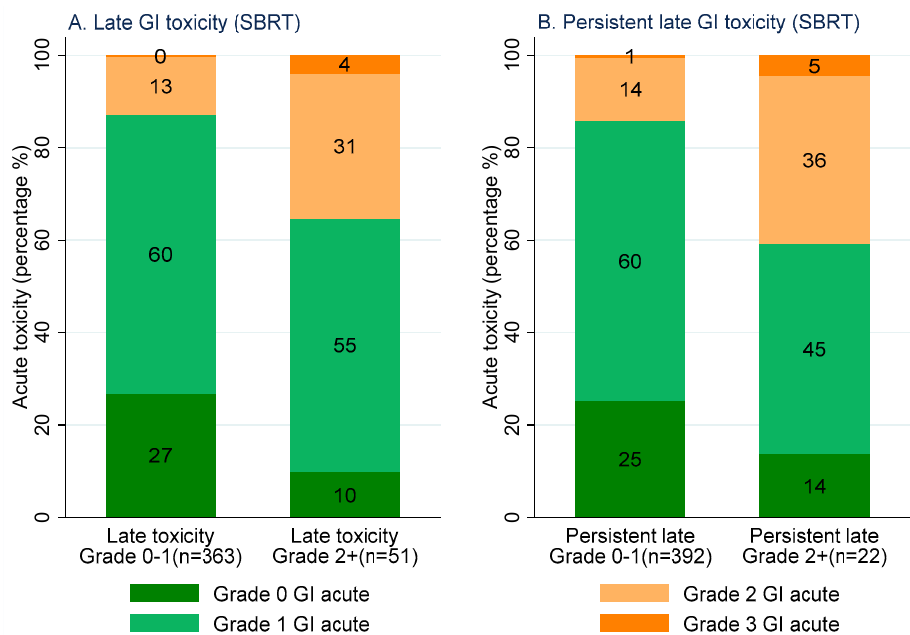
Figure 3. Stacked bar graph: maximum grade CTCAE acute GI toxicity experienced for patients with Grade 0–1 (left of each figure) and Grade 2+ (right of each figure) late GI toxicity following SBRT ( left ). Maximum grade CTCAE acute GI toxicity experienced by patients with grade 0–1 (left of each figure) and grade 2+ (right of each figure) persistent late GI toxicity following SBRT ( right ). Univariable and multivariable logistic regression for predicting worst grade 2+ late GI toxicity (6–24 months) and persistent grade 2+ late GI toxicity in the SBRT group is presented in Table 4. In the univariable analysis baseline EPIC-26 bowel sub-domain score was predictive for late grade 2+ GI toxicity ( p = 0.004). Acute grade 2+ GI events ( p < 0.0001) and worst EPIC-26 bowel sub-domain score in the acute setting ( p = 0.04) was also predictive for grade 2+ late GI toxicity. In univariable analysis, acute grade 1+ rectal bleeding ( p = 0.04), grade 2+ diarrhoea ( p = 0.01) and grade 1+ rectal pain ( p < 0.0001) were individually associated with late rectal toxicity. The remainder of the baseline and treatment factors did not demonstrate a statistically significant association. In multivariable analysis, acute grade 2+ GI toxicity (OR 3.68, CI (1.89–7.17), p < 0.0001) remained statistically significantly associated with grade 2+ late GI toxicity (6–24 months). The AUC for multivariable models’ ability to predict grade 2+ late GI (6–24 months) toxicity after SBRT was 0.66 (95% CI, 0.57–0.75). Univariable analysis for predicting persistent late grade 2+ late GI events is summarised in Table 4. Due to low number of events multivariable regression was not performed. Table S7 in the Supplementary Materials summarises logistic regression analysis to predict late grade 2+ GI toxicity after 12